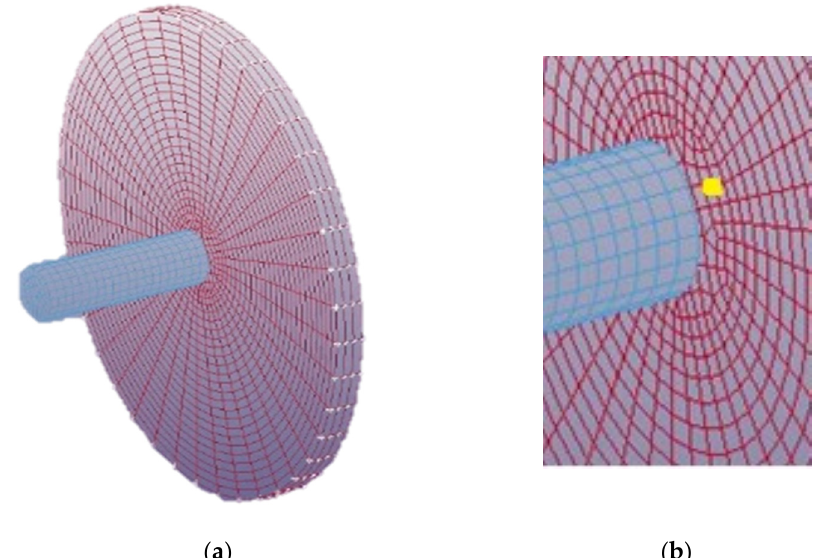
Figure 7. ( a ) Representative structured mesh used for the model with 4.00 mm target thickness. ( b ) Enlarged view of the point (Yellow) considered for x -axis stress.